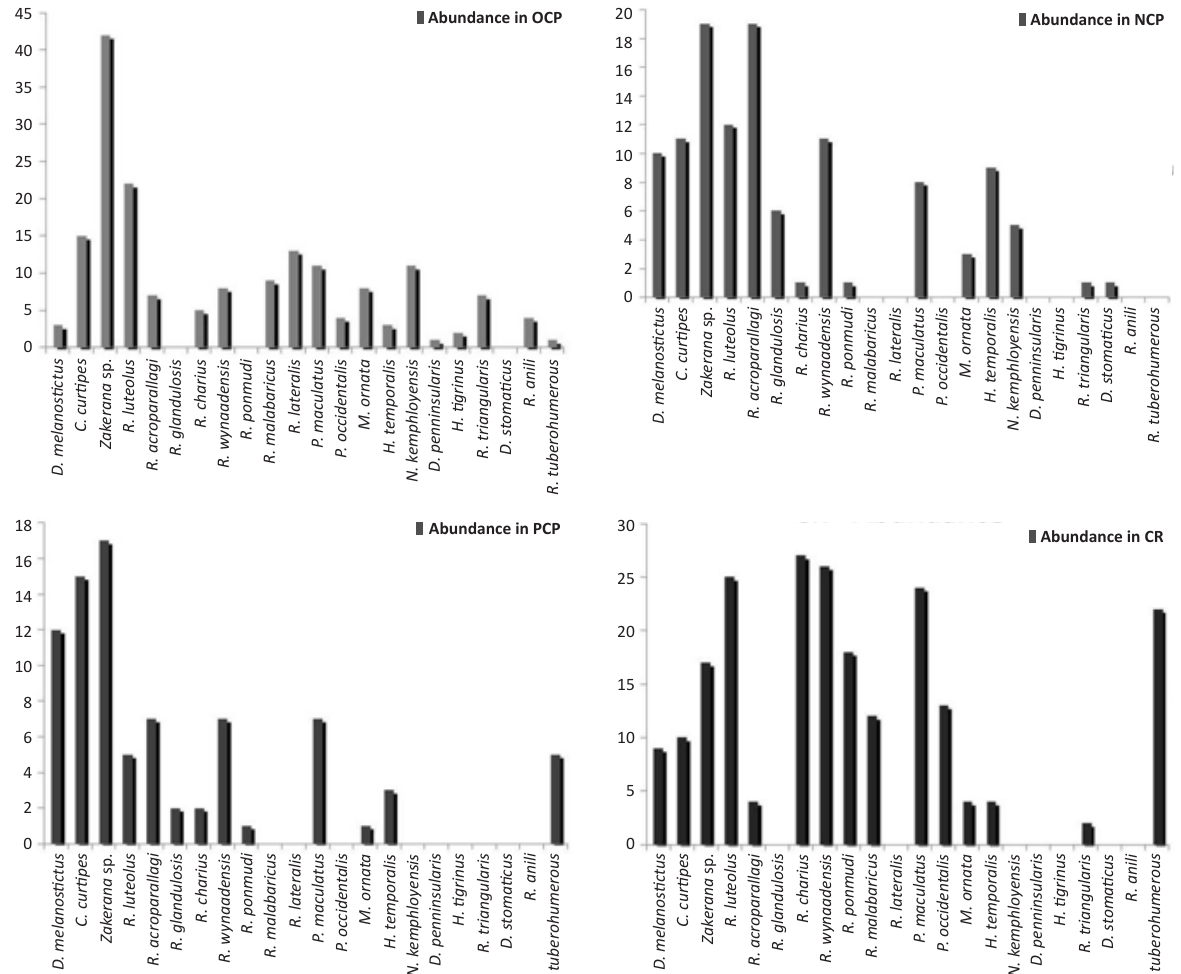
Figure 3. Abundance of amphibians across three different coffee plantation regimes and control region.